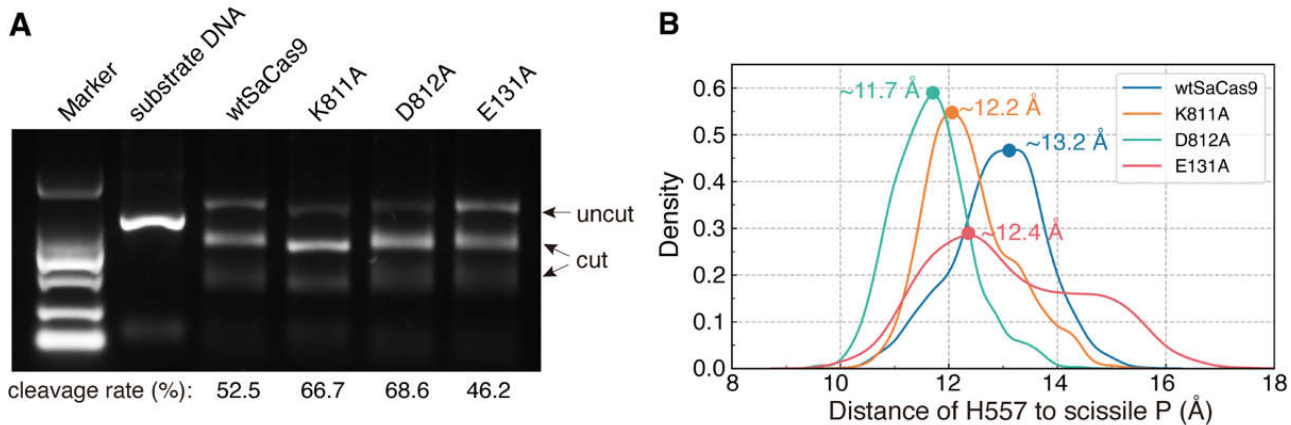
Figure 8. The effects of the REC and WED domains on the DNA cleavage by the HNH domain. ( A ) The cleavage activity of SaCas9 and its mutants (measured by ImageJ). ( B ) MD distance distri- butions between the catalytic residue H557 and the scissile P (D 557-P ) of SaCas9 and its mutants.